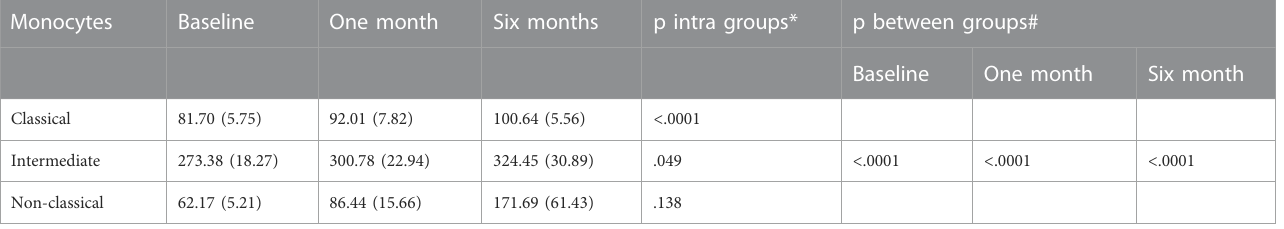
TABLE 6 Level of expression (a.u.) of the receptor CX3CR1 in monocyte subtypes, throughout the study. Monocytes Baseline